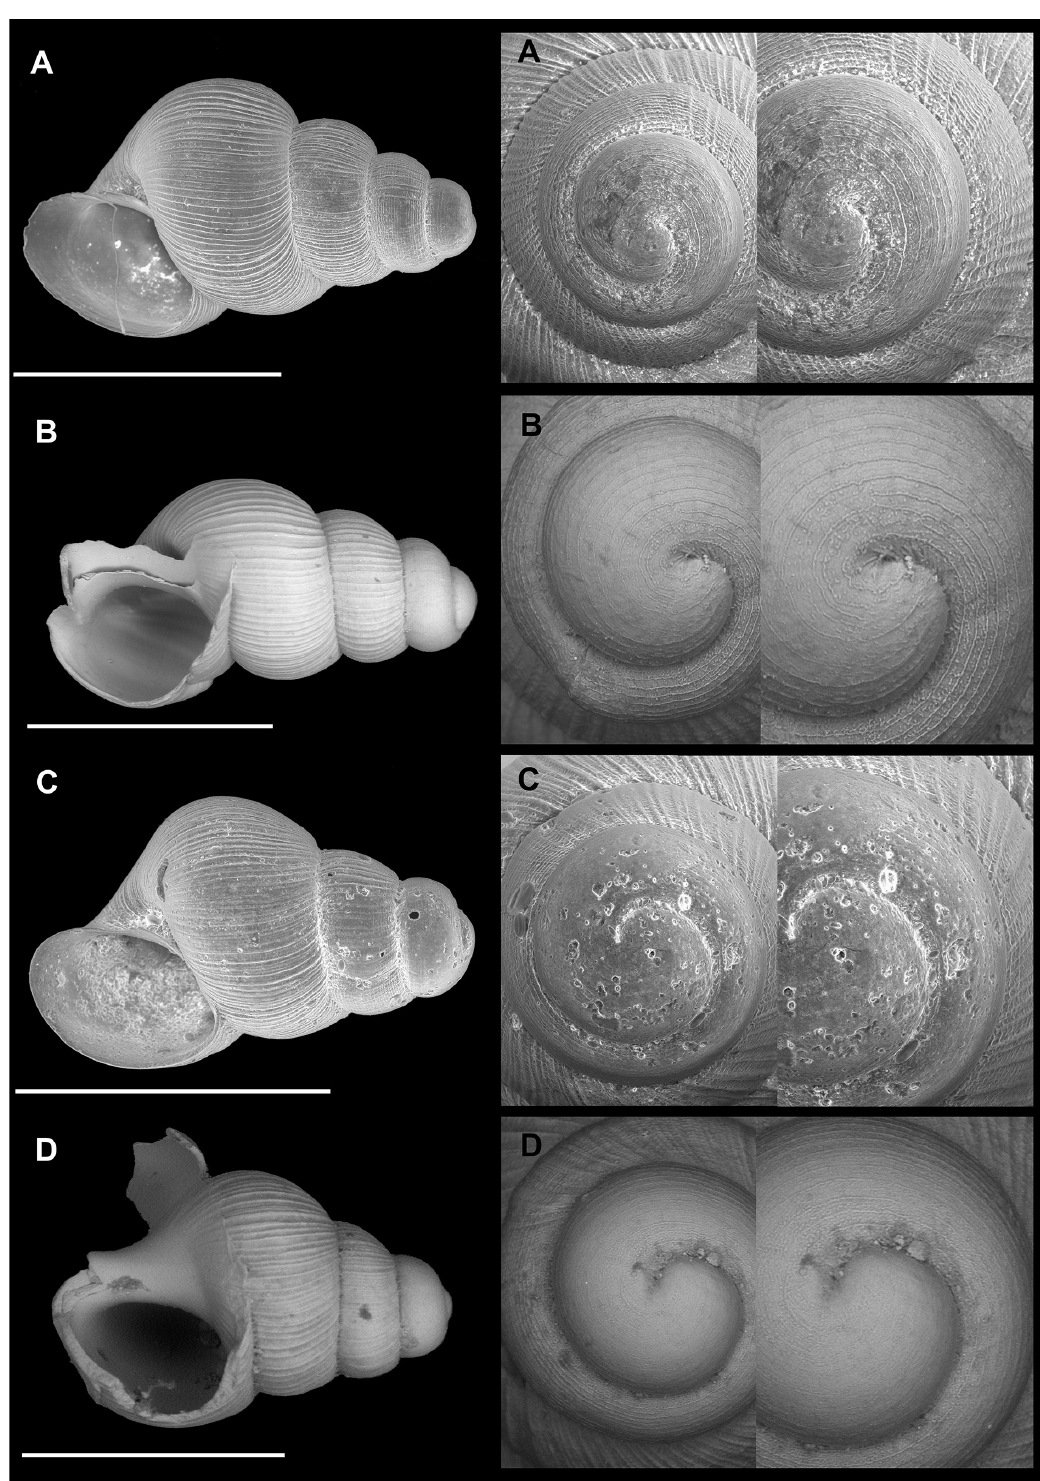
Fig. 8. A . Plagigeyeria reischuetzorum sp. nov., Bjeljani, Dabarsko Polje, Vrelo Vruljak, paratype (SBMNH 632724). B . P. pseudocostellina sp. nov., Blagaj, side spring of Buna at left bank, paratype (SBMNH 626414). C . P. mostarensis Kuščer, 1933, Blagaj Izvor Bune (SBMNH 626411). D . P. mostarensis Kuščer, 1933, Hodbina, Izvor Bunice (SBMNH 626405). Scale bars = 1 mm (SEM SBMNH Vanessa